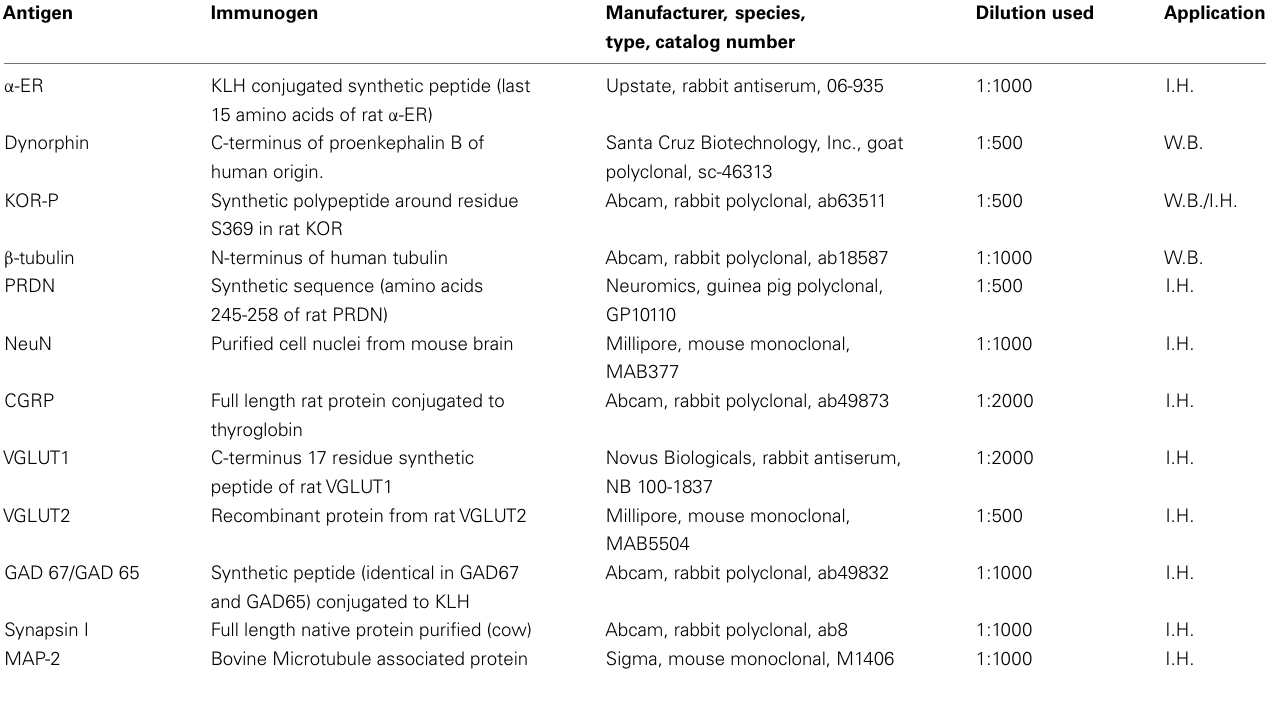
Table 1 | List of primary